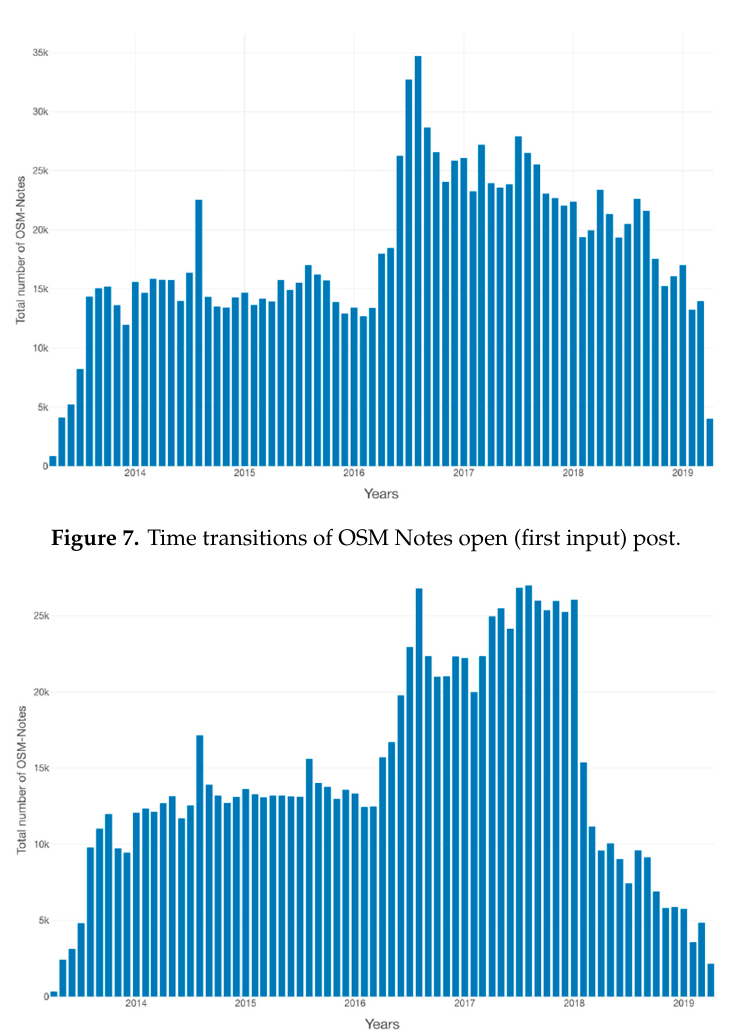
Figure 8. Time transitions of OSM Notes closed (resolved) post.